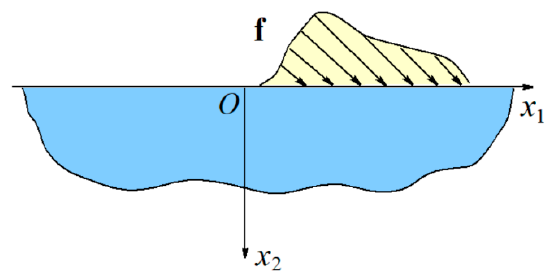
Figure 1. Elastic half-space under the action of a prescribed surface load.